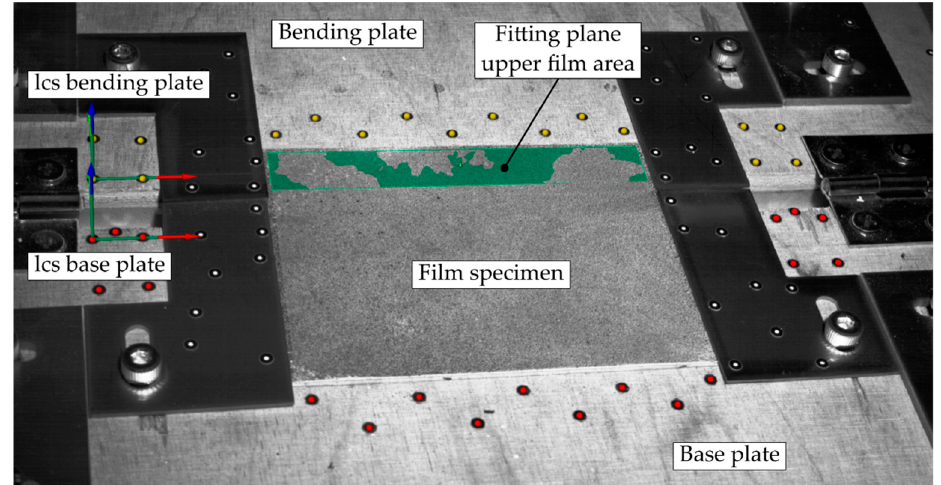
Figure 5. Measurement recording of the ARAMIS SRX before the start of the measurement procedure with local coordinate systems (lcs) and markers to track the position of the components during the bending process as well as the created fitting plane of the upper film area to determine the forming ratio.